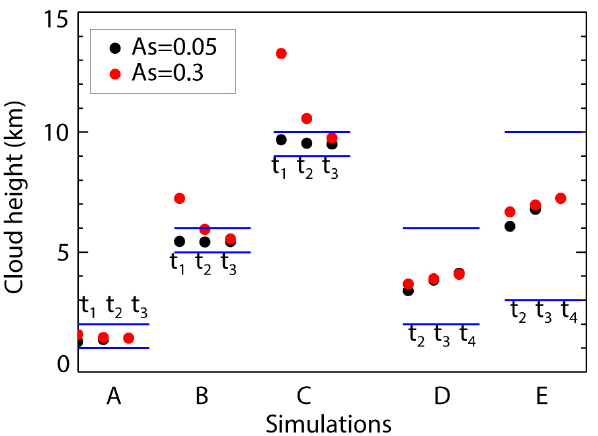
Figure 3. Three examples of Cloudnet cloud vertical distributions: two single-layer cases and one multilayer case. The distributions are based on 1h of data centered at the SCIAMACHY overpass time (about